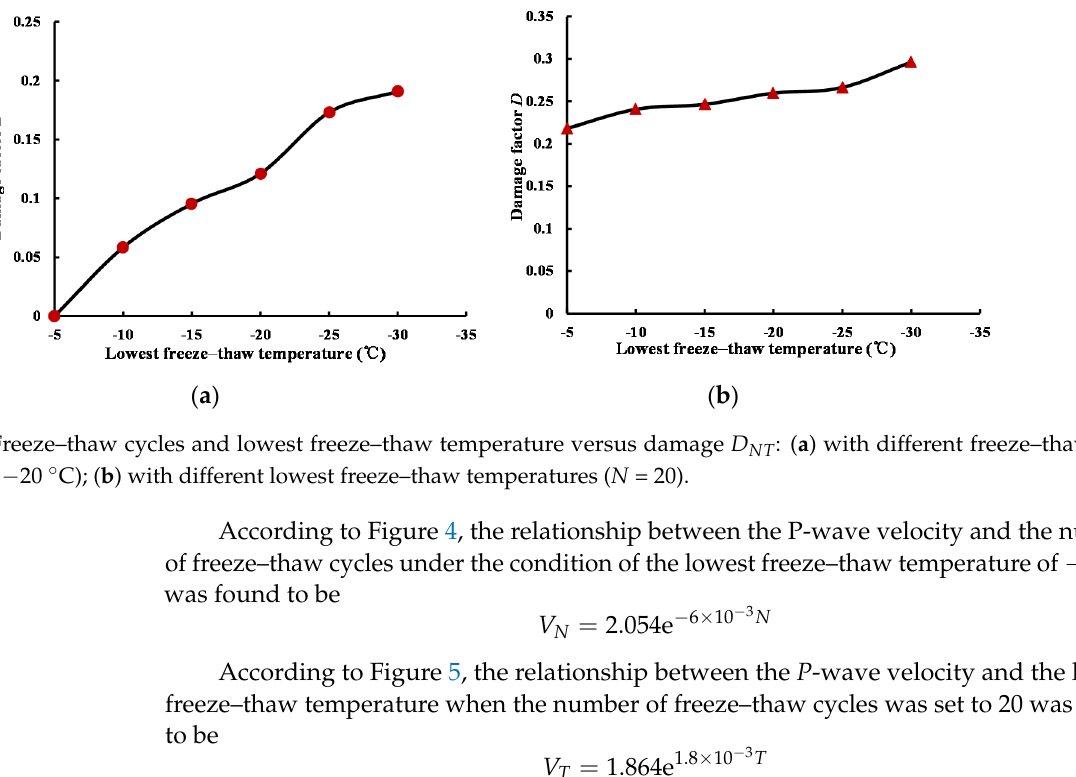
Figure 5. Freeze–thaw cycles and lowest freeze–thaw temperature versus P -wave velocity: ( a ) with different freeze–thaw cycles ( T = − 20 °C); ( b ) with different lowest freeze–thaw temperatures ( N = 20).